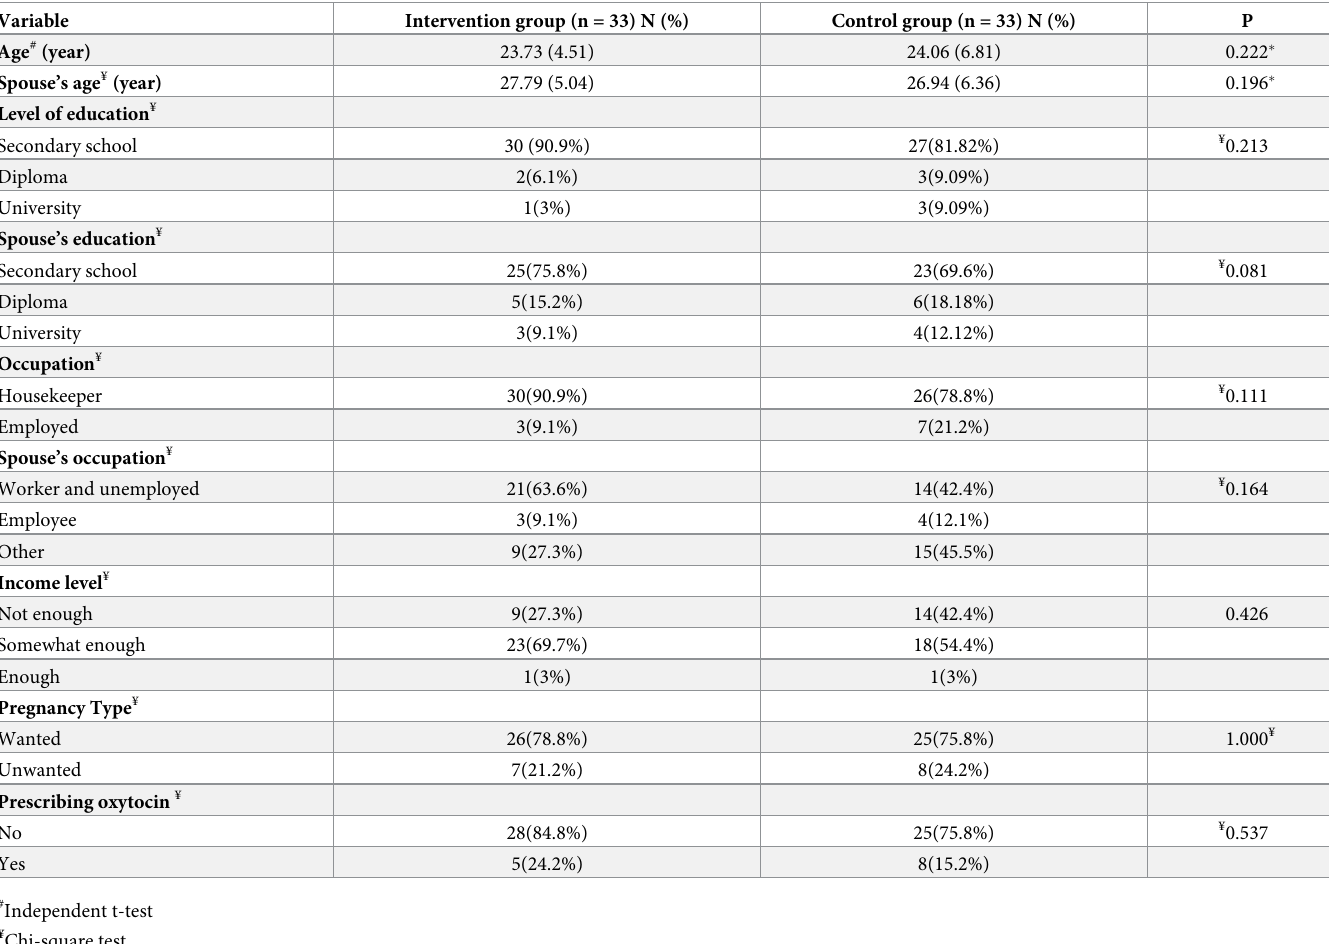
Table 1. The socio-demographic and obstetrics characteristics of participants in the intervention and control